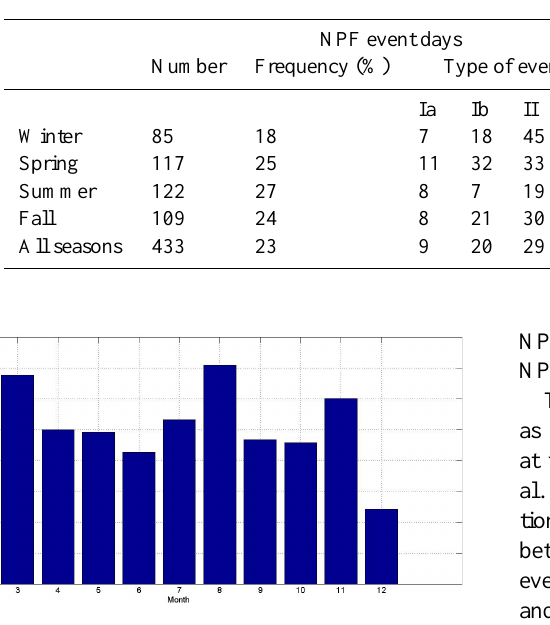
Table 1. Statistics on event, non-event and undefined days observed at the Puy de Dôme (February 2007–February 2012). In case of event days, additional statistics concerning the type of event are reported.